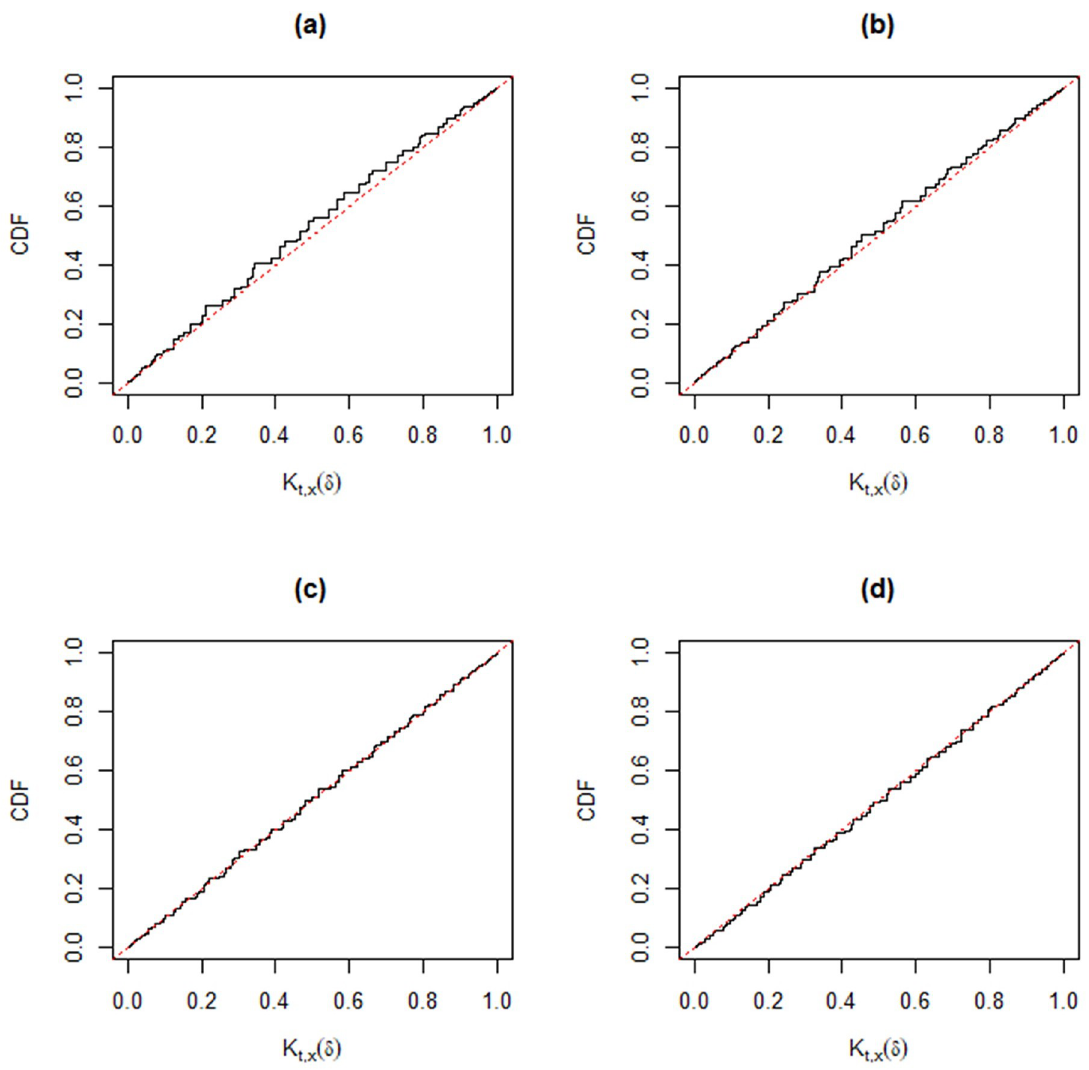
Fig 7. Distribution functions of K ( δ ) (black) compared with that of Unif(0, 1) (gray) based on Monte Carlo samples from the t , x trinomial distribution versus p 12 for fixed n = 50 and p 11 = 0.1. Panel (a): p 12 = 0.1. Panel (b): p 12 = 0.2. Panel (c): p 12 = 0.3. Panel (d): p 12 =